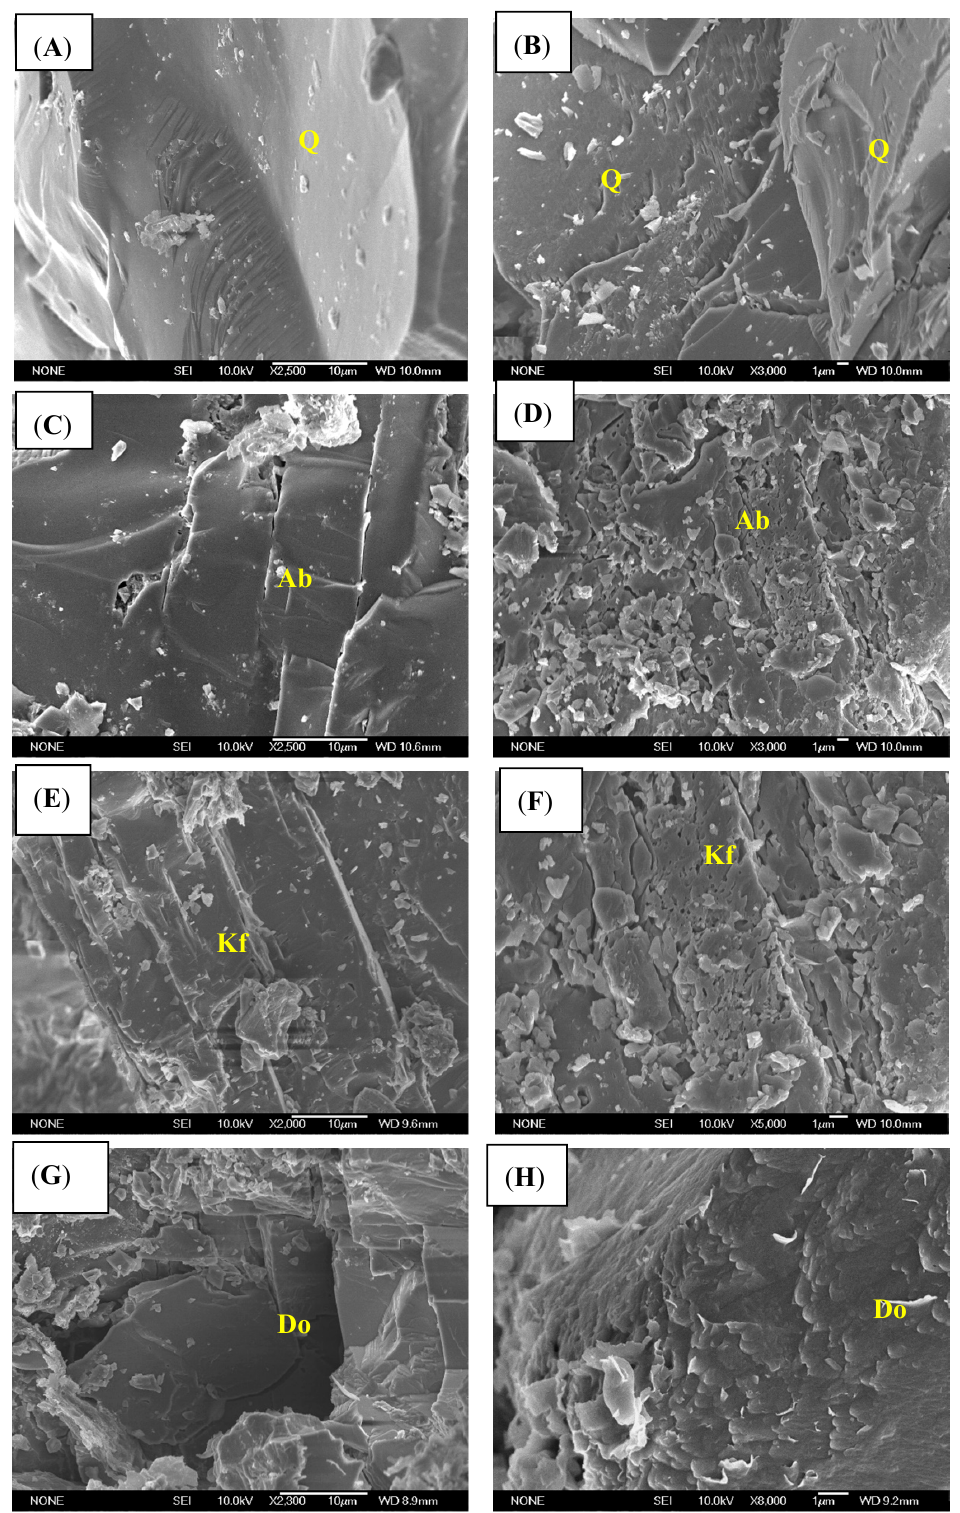
Figure 5. Scanning electron photomicrographs of pre-and post-experimental cores. ( A ) Quartz before the experiment; ( B ) Quartz after the experiment; ( C ) detrital albite before the experiment; ( D ). detrital albite after the experiment; ( E ) K-feldspar before the experiment; ( F ) K-feldspar after the experiment; ( G ) dolomite before the experiment; ( H ) dolomite after the experiment. Q—quartz; Ab—detrital albite; Kf—K-feldspar;